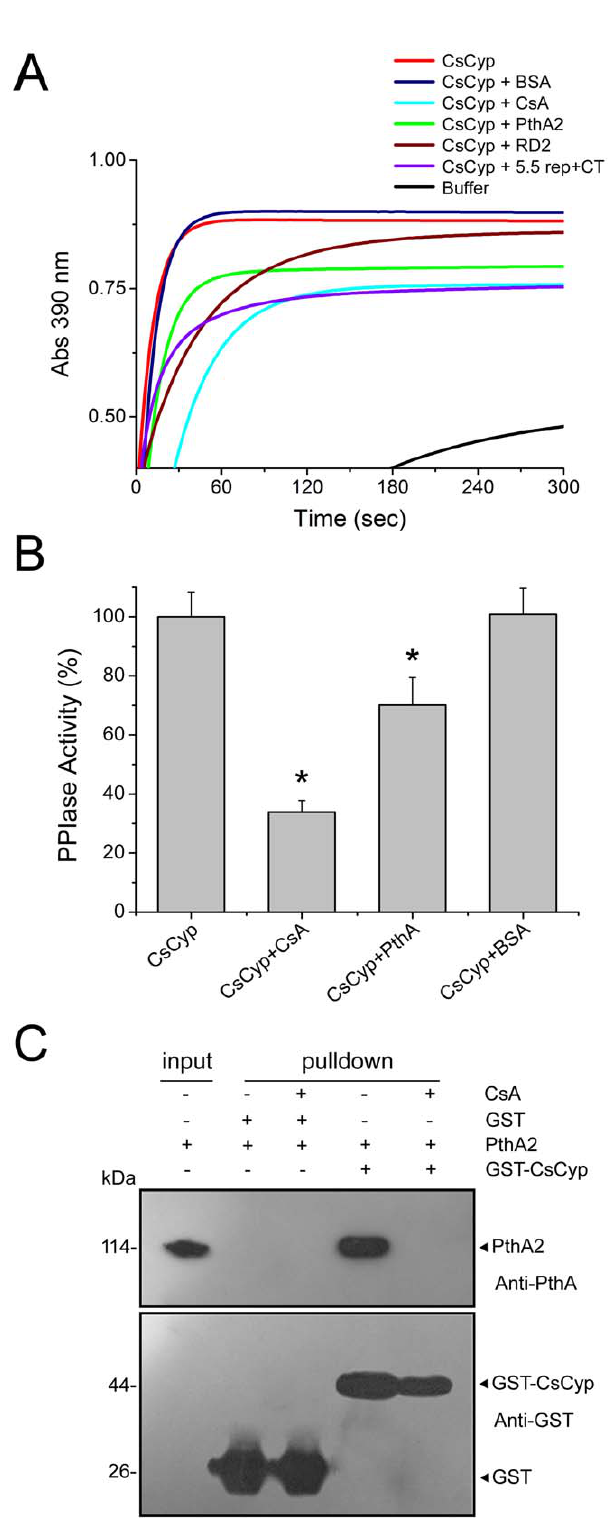
Figure 5. PthA2 inhibits the PPIase activity of CsCyp. (A) The PPIase activity of recombinant CsCyp protein was evaluated by the a - chymotrypsin-coupled assay. Enzyme activity was measured immedi- ately after the addition of a -chymotrypsin and the substrate into the reaction mixture. The PPIase activity of CsCyp reached a plateau within 30 to 60 s after the start of the reaction (red). This activity was drastically reduced in the presence of 30 nM CsA (light blue), as compared to buffer only, as control (black). PthA2 (green), its internal